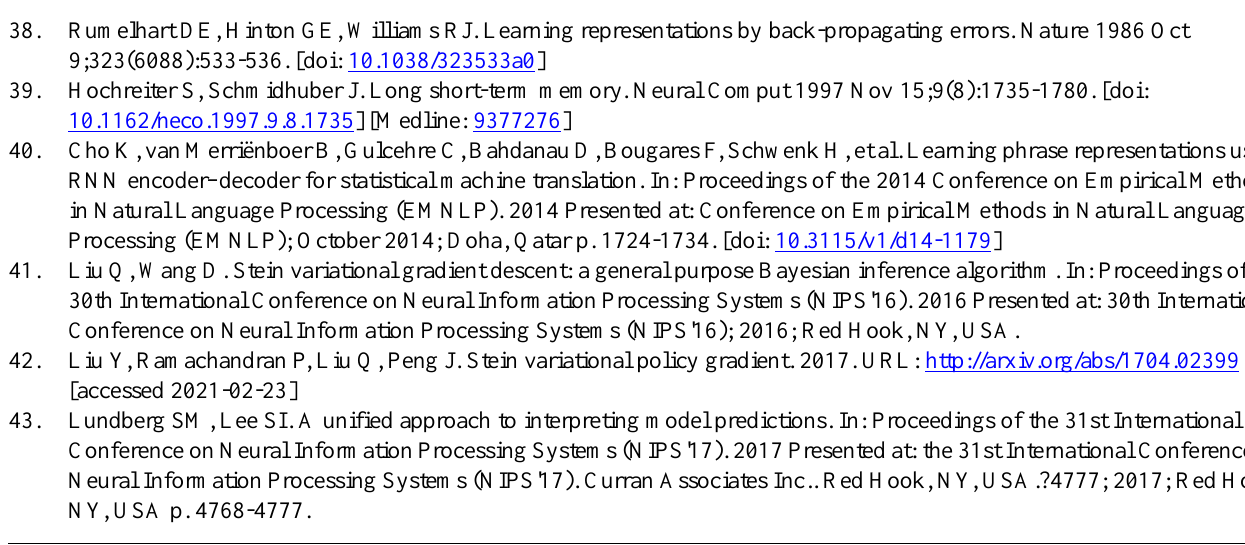
AUC-PRC: area under the precision-recall curve AUC-ROC: area under the receiver operating characteristics curve Deep-DARWiN: Domain Alignment and Data Wrangling with Deep Generative Models EMA: ecological momentary